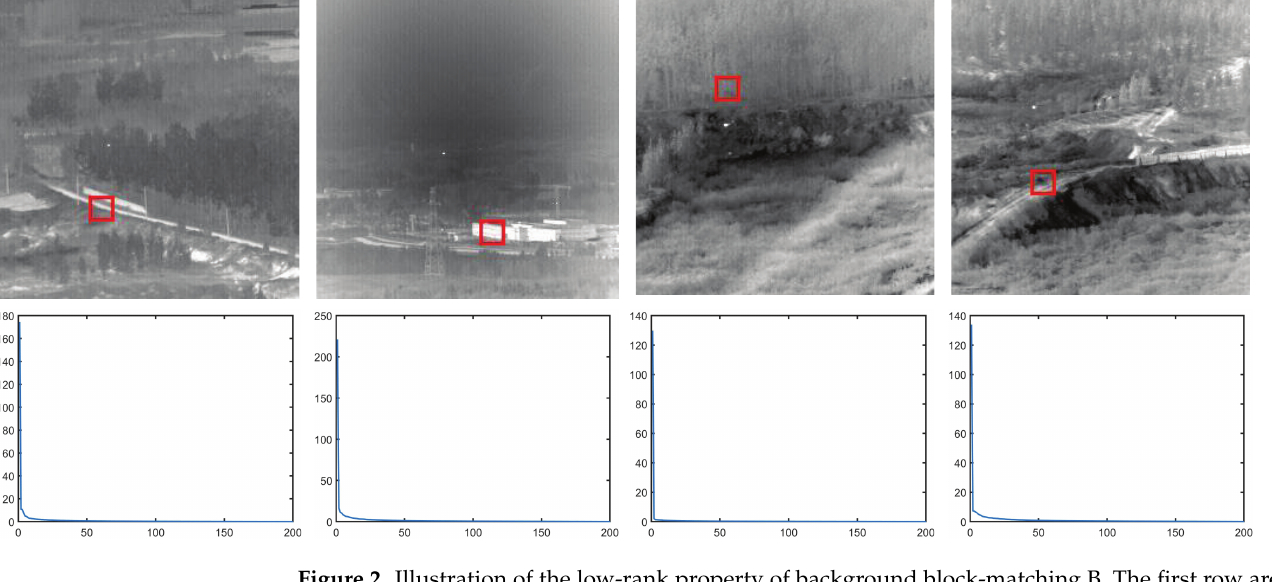
Figure 2. Illustration of the low-rank property of background block-matching B. The first row are four images, each with a background reference block with a red border, and the second one are the singular values of background block-matching B constructed using four reference